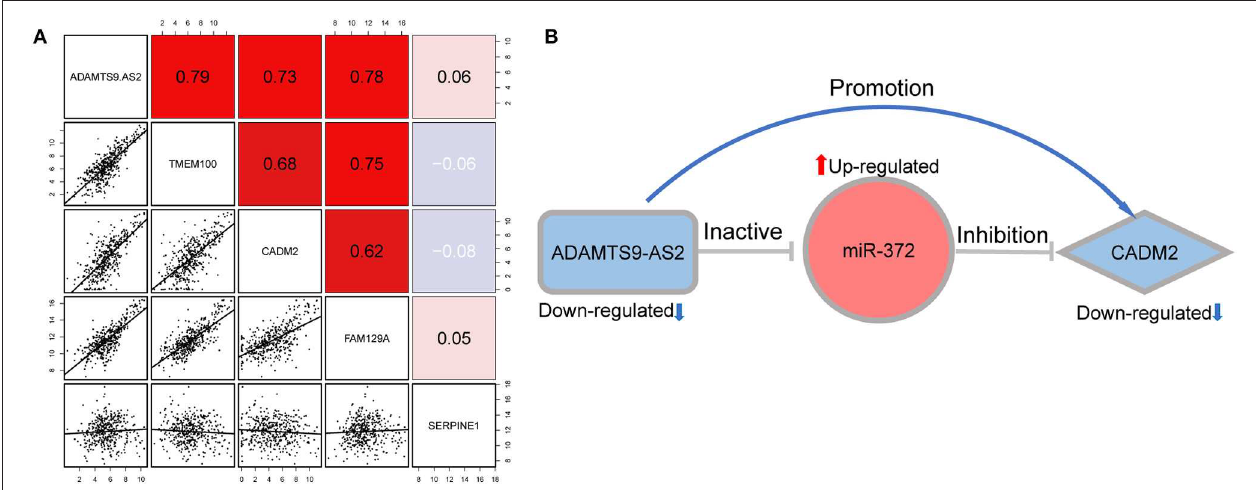
FIGURE 5 | (A) Correlation between lncRNA ADAMTS9-AS2 and four mRNA (TMEM100, CADM2, FAM129A, and SERPINE1). (B) The ADAMTS9-AS2/ miR-372/ CADM2 regulatory axis which perfectly conformed to the ceRNA